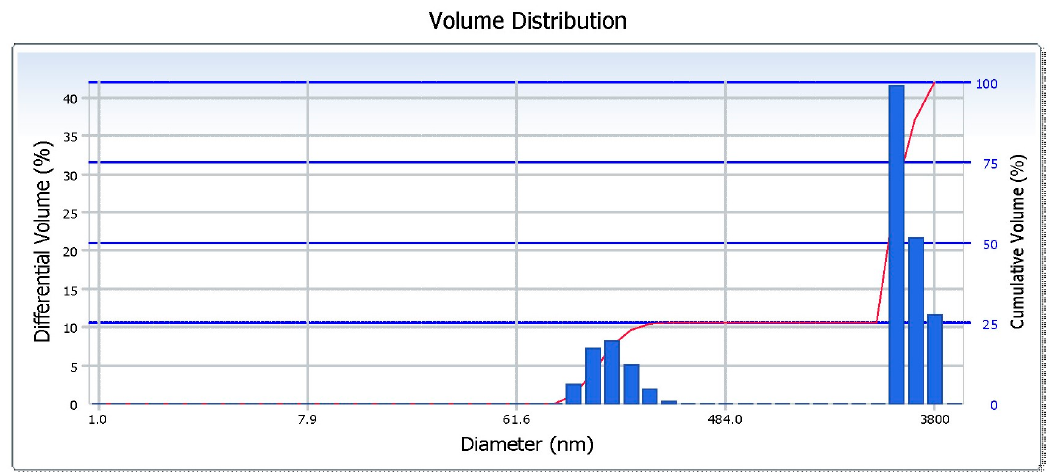
Figure 5. Silica particle diameter measured by dynamic light scattering (DLS). Table 2. The sample color and various diameters of silica nanoparticles of samples.